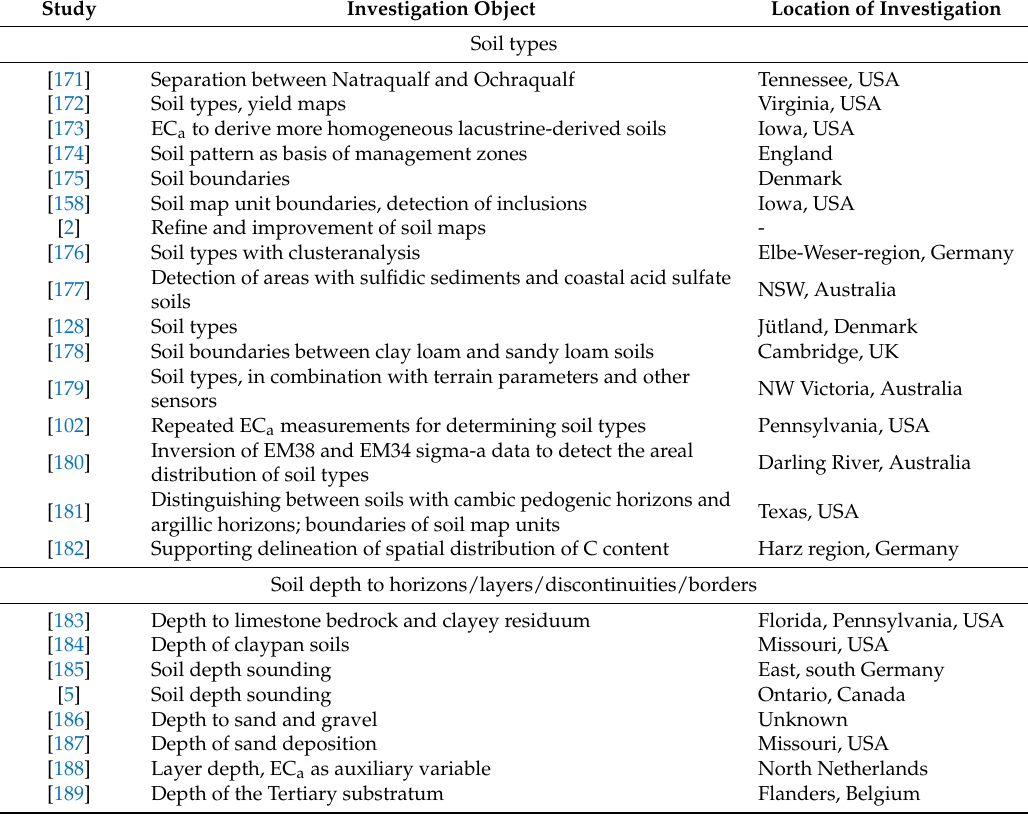
Table 4. Literature indicating derivations of soil types and patterns as well as further soil parameters from EM38-EC a